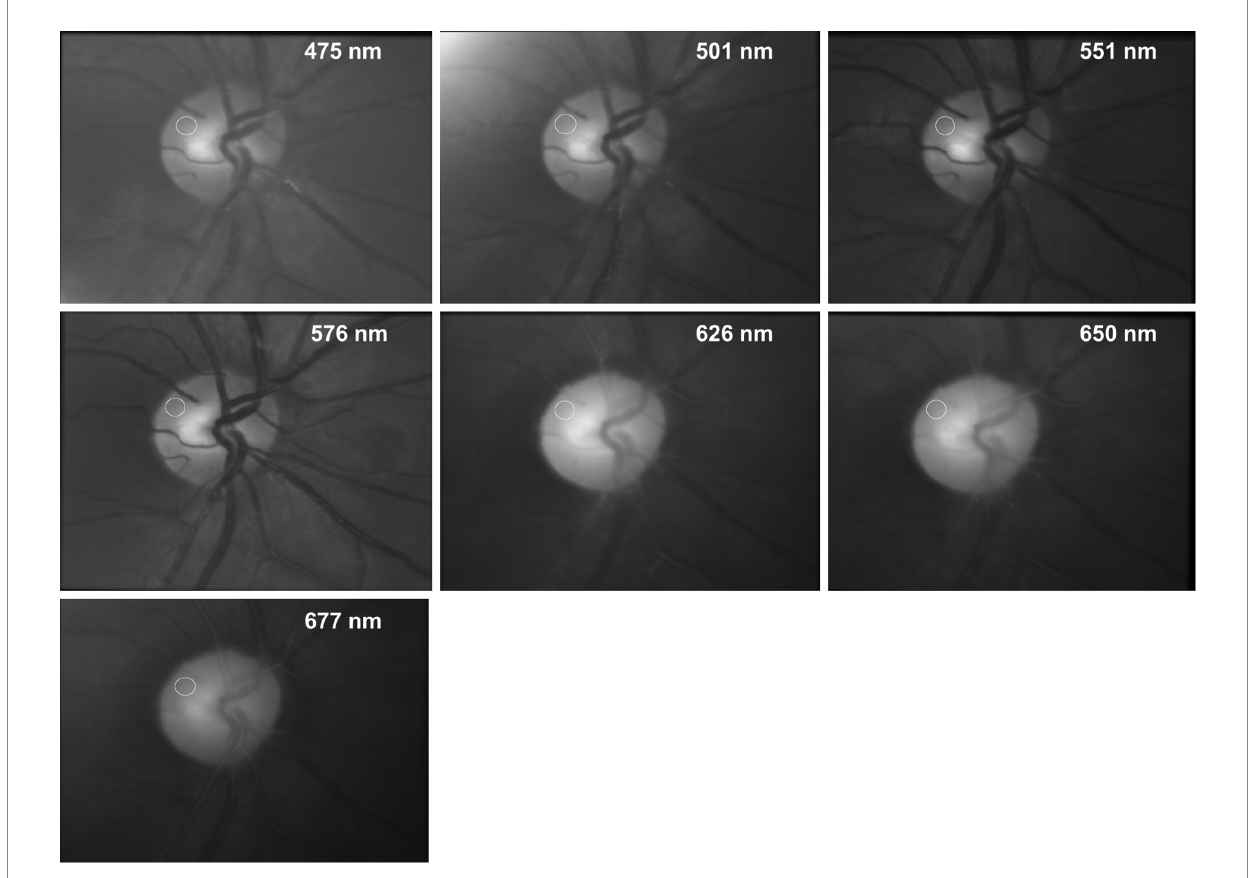
FIGURE 2 Fundus images of the same subject for different wavelengths. The images show the average image of the entire registered video sequence. The white circle shows the AOI were the PAA was taken from (see Figure